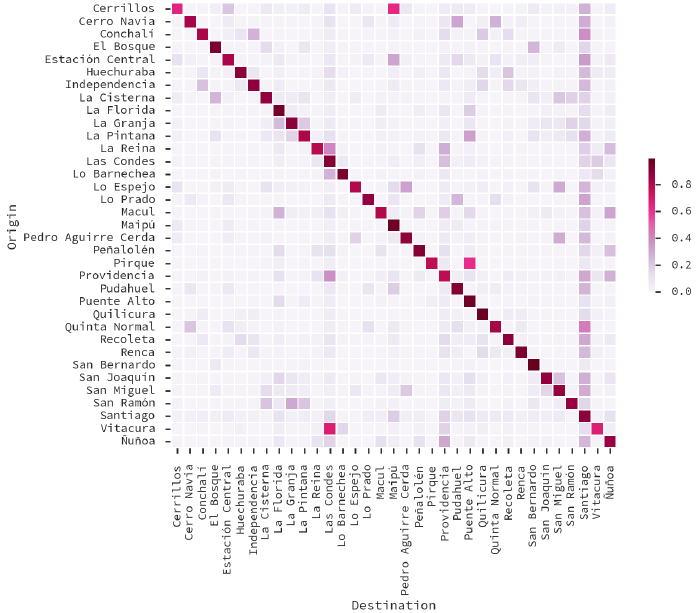
Figure 2. Origin-Destiny (OD) matrix of municipalities for Santiago, according to the Origin-Destiny Survey